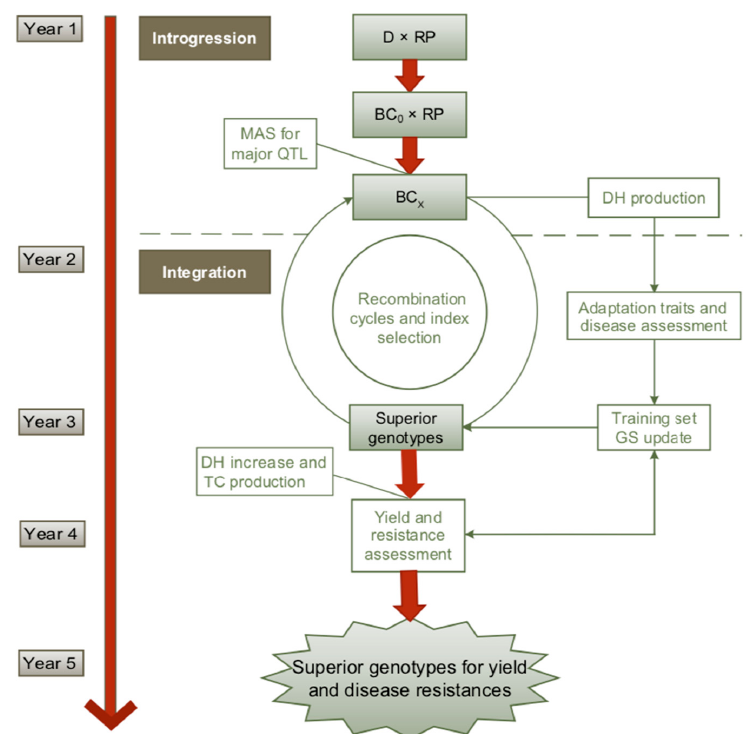
Figure 3. Schematic illustration of a rapid genomics-assisted breeding approach for using genetic resources in maize [124]. D = donor of resistance, RP = recurrent parent, BC = , backcross, MAS = marker assisted selection, DH = doubled haploid lines, GS = genomic selection, TC = testcross.